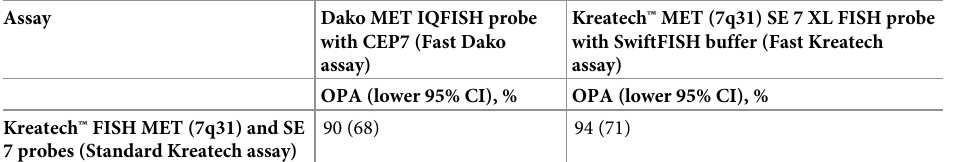
Table 3. Overall percentage agreement (OPA) between FISH